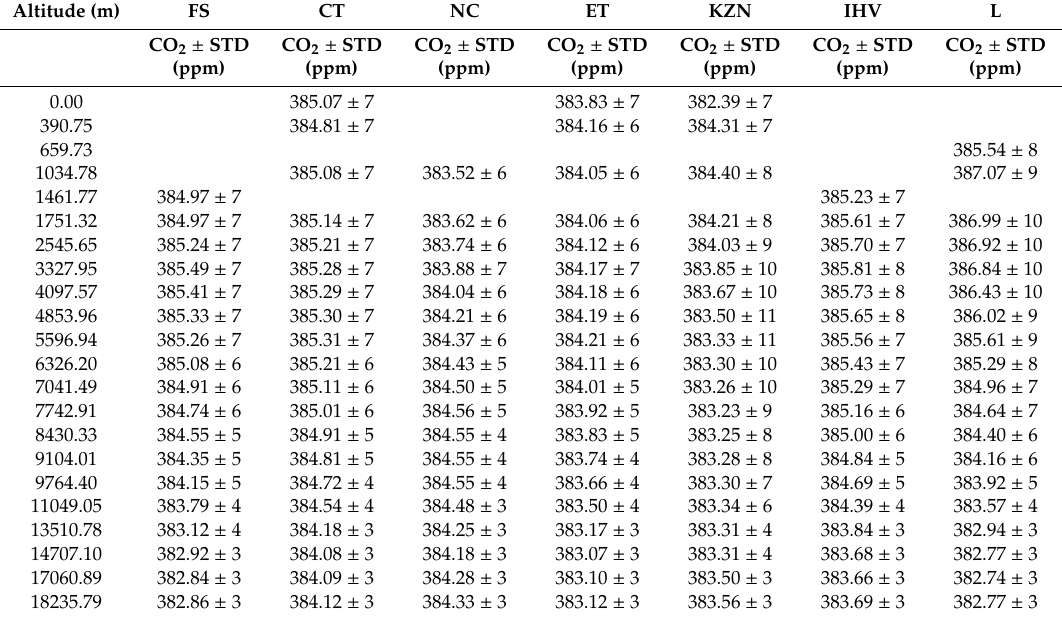
Table A4. Spring (SON) horizontally averaged CO 2 data and the associated standard deviations at di ff erent altitudes used for vertical profiles at the di ff erent study areas. Altitude